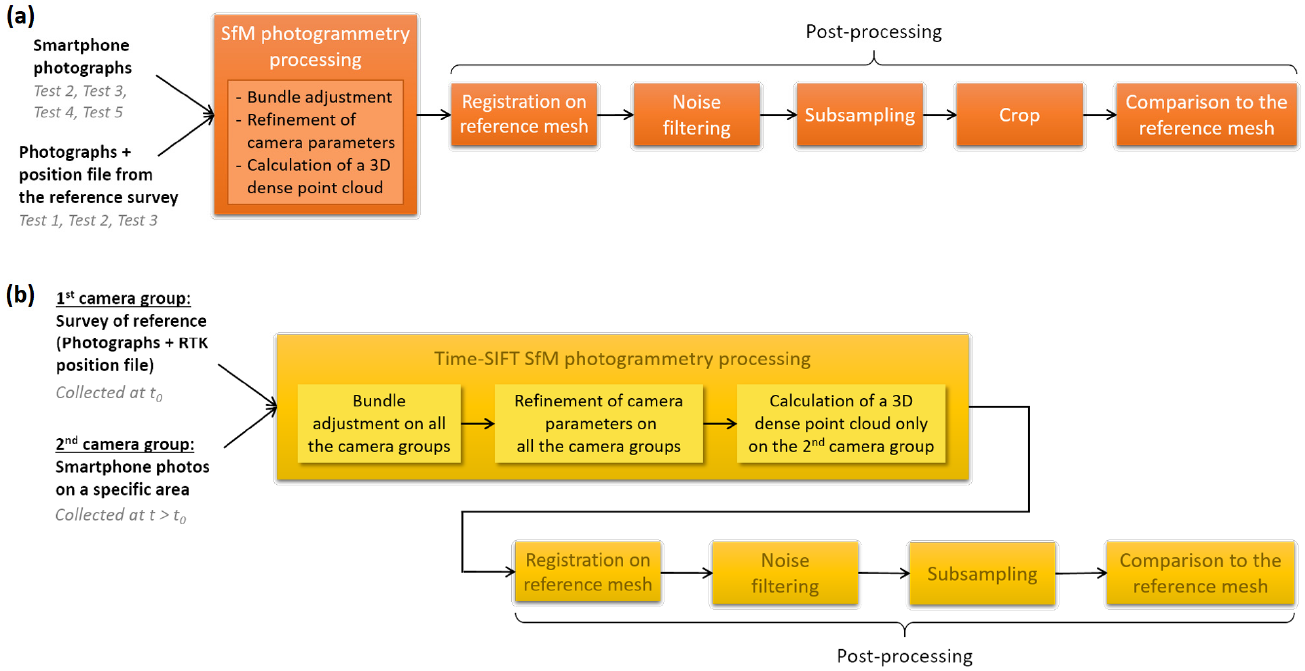
Figure 5. ( a ) Processing chain with «classical» SfM photogrammetry and postprocessing in Cloud- Compare used for Tests 1 to 5. ( b ) Processing chain with Time-SIFT SfM processing and postprocessing in CloudCompare used for Test 6.